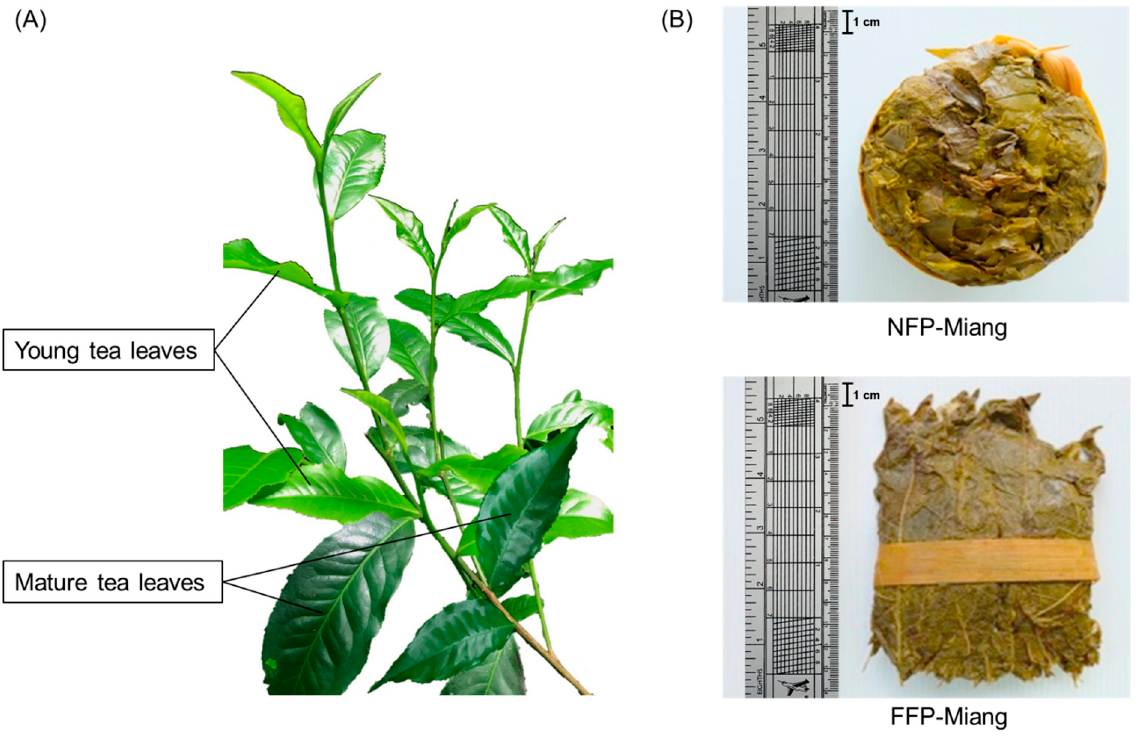
Figure 1. The appearance of tea leaves, i.e., young and mature leaves ( A ), non-filamentous fungi-process-based fermented leaves (NFP-Miang) and filamentous fungi-process-based fermented leaves (FFP-Miang) ( B